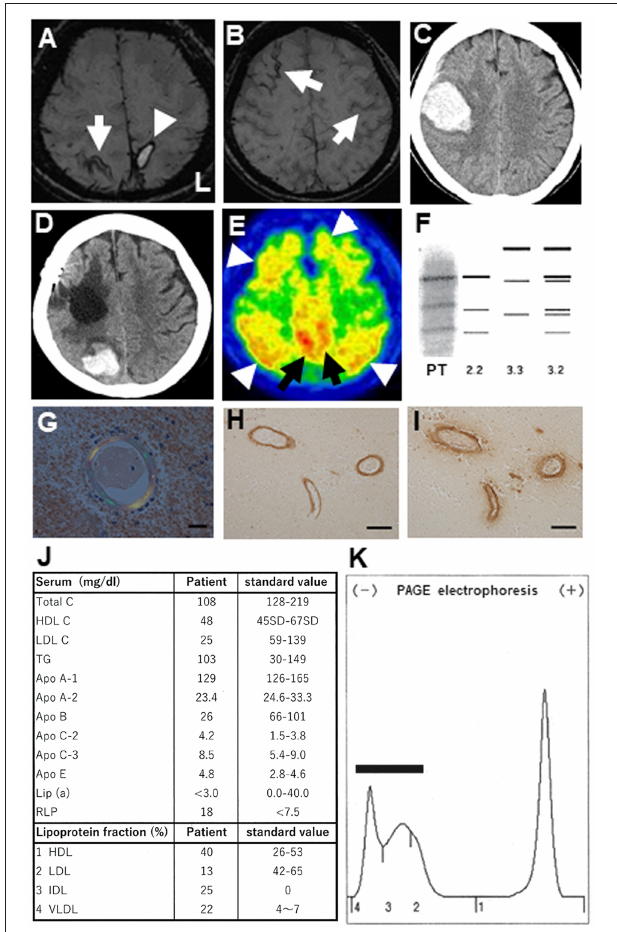
FIGURE 1 | (A) Brain magnetic resonance imaging (MRI; 3T System, Skyra, Siemens, Germany) at the first admission. Susceptibility weighted images (SWI) showing a cortical hemorrhage (arrowhead) at the left parietal lobe cortex and cortical superficial siderosis (cSS) in the right parietal cortex (arrow). (B) In the same MRI, cSS was additionally observed in the left and right frontal cortices (arrows). (C) Brain computed tomography (CT) showing a second lobar hemorrhage at the right frontal subcortical area concurrent with left hemiparesis. (D) Brain CT showing a third lobar hemorrhage at the right parieto-occipital subcortical region. (E) 11 C-PiB PET revealing widespread 11 C-PiB retentions in the cerebral cortices (arrowheads) and precuneus (arrows). (F) Electrophoresis revealing a 2/2 pattern in the apolipoprotein E phenotype for this patient (PT). (G) Congophilic amyloid deposits shown in blood vessels of the resected brain tissue, as shown using polarizing microscopy (Scale bar: 20 µ m). (H,I) A β -reactive structures in blood vessel walls identified by immunohistochemistry using anti-A β 1-42 (H) and anti-A β 1-40 (I) antibodies. Scale bars: 100 µ m. (J) Laboratory serum results from the patient’s first admission. (K) Serum lipoprotein electrophoresis reveals a broad- β pattern (bar), where intermediate-density lipoprotein (fraction 3) and very-low-density lipoprotein (fraction 4) are aberrantly